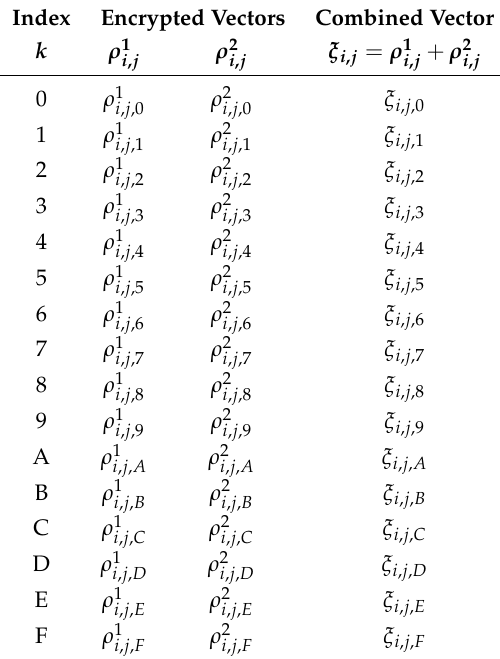
Table 7. Example of Combined Encrypted Substitute Vector Construction for N i,j =